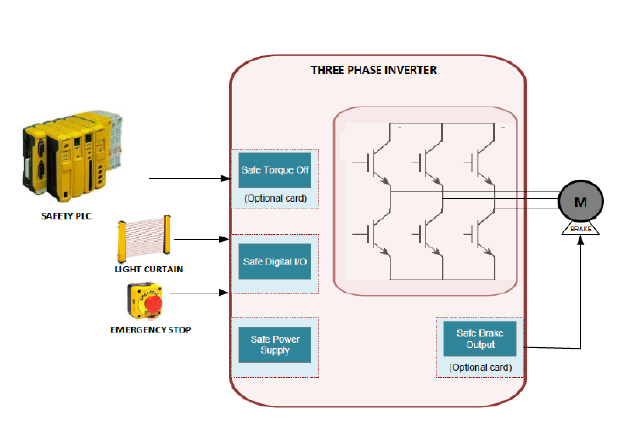
Figure 1. Block Diagram of Safety integrated